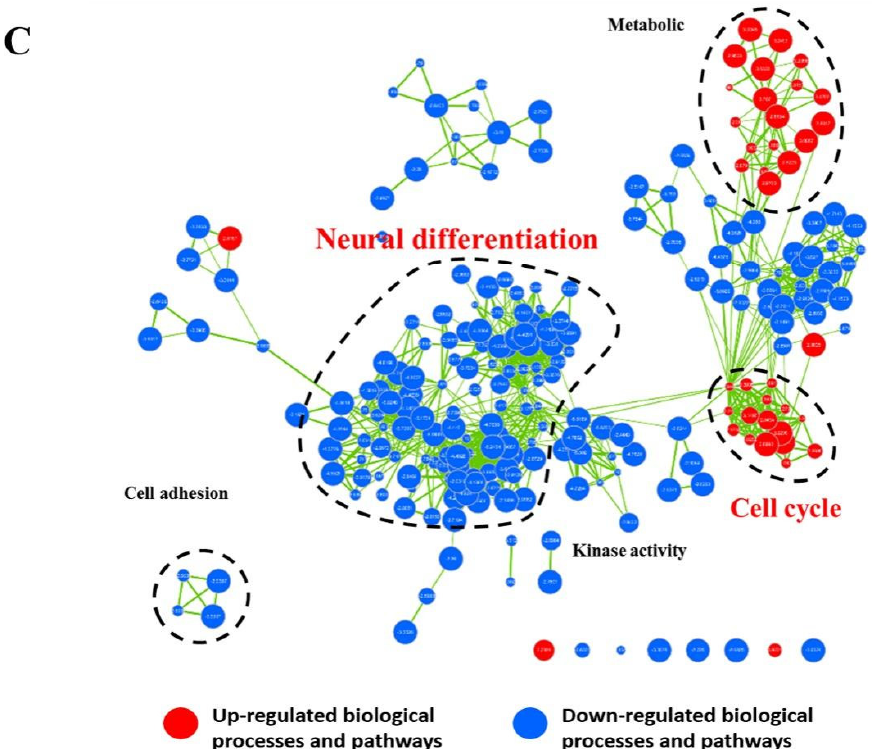
Figure 4. BHB perturbed chromatin bivalency and resulted in the alteration of neural differen‑ tiation processes. ( A ) Workflow of neural precursor cell isolation and 3OHB treatment for tran‑ scriptome analysis. ( B ) Up, immunocytochemical staining used to validate the alteration of the differentiation status of NSCs in the presence of 0.02, 0.2 and 2 mM 3OHB; down, volcano plot of the transcriptomic dataset showing changes of gene expression upon BHB administration (5 days; n = 3 biological replicates) ( p < 0.05; log2(fold change) > 0.25 or < − 0.25. ( C ) GSEA extraction‑enriched gene ontology map derived from the transcriptomic data. Red nodes indicate signaling pathways upregulated by 3OHB while blue nodes represent signaling pathways downregulated by it in NSCs. The cellular metabolic processes indicated by circles were increased by 3OHB treatment; biological processes related to neural differentiation were significantly inhibited ( p < 0.001) while processes related to the cell cycle were significantly promoted by 3OHB ( p <